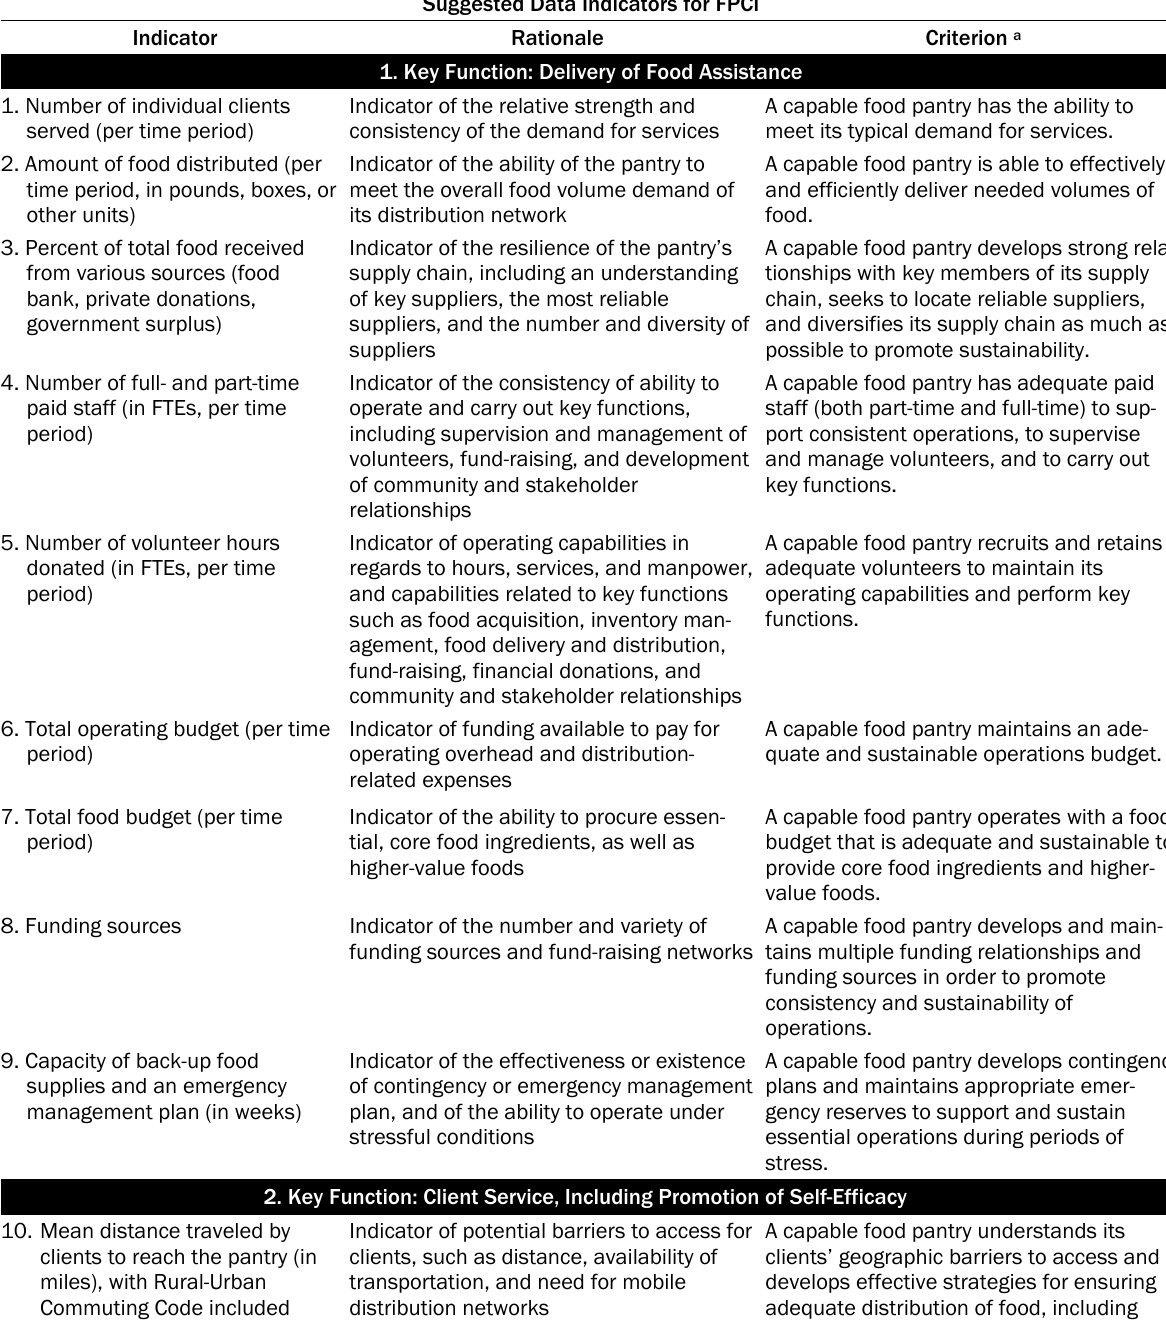
Table 2. Food Pantry Capability Index (FPCI) Development Table: Possible Data Indicators for Development of FPCI with Rationale and “Criterion Statements” for Each Item Suggested Data Indicators for